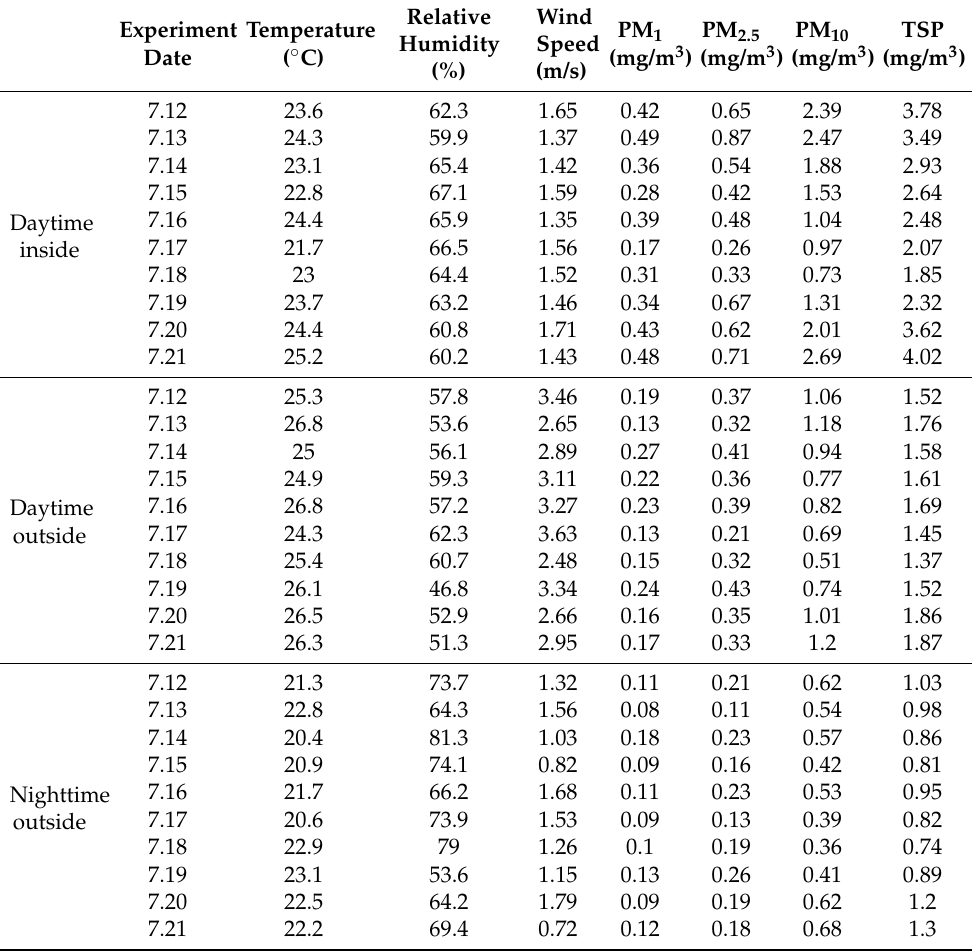
Table 2. Average ambient meteorological conditions and PM concentrations during each of the ten daytime inside, daytime outside, and nighttime outside experiments.